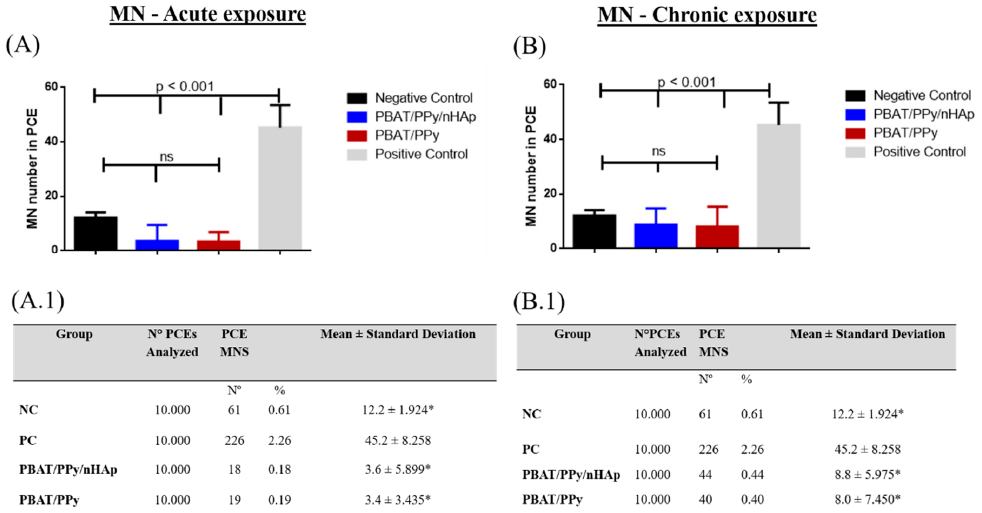
Figure 5. Mean of micronuclei found in 2000 PCEs after acute exposure per animal. ( A ) Mean of micronuclei found in 2000 PCEs after chronic (72 h) exposure per animal. ( B ) Table with frequencies of micronucleated polychromatic erythrocytes (PCEMNs) in Wistar rat bone marrow exposed to the sca ff olds. ( A.1 ) acute exposure after 48 h. ( B.1 ) chronic exposure after 72 h. Legend: NC = negative control; PC = positive control (cyclophosphamide 50 mg / kg); PCEs = polychromatic erythrocytes in the table. * indicates a statistically significant di ff erence ( p < 0.001), compared to